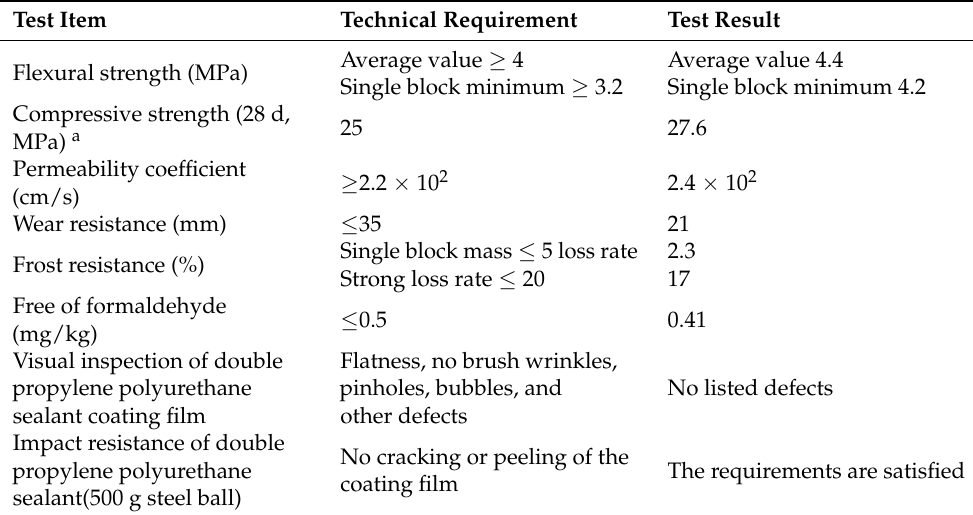
Table 2. Technical data of the permeable pavement materials installed at the case study’s site: Riv- erside Park in Quanzhou, Fujian Province, China.